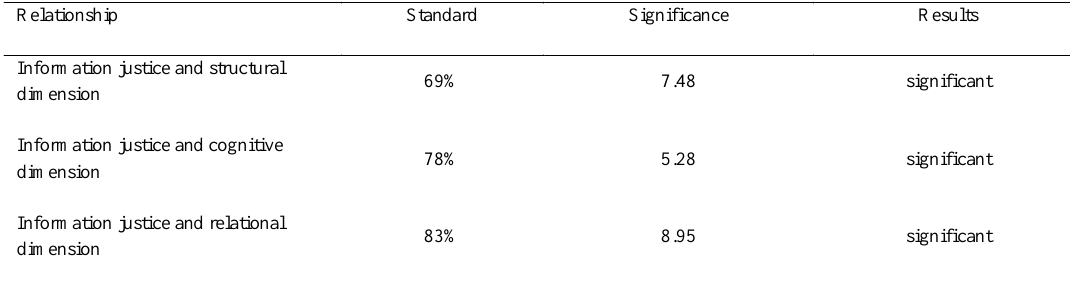
Table 6: Results of structural